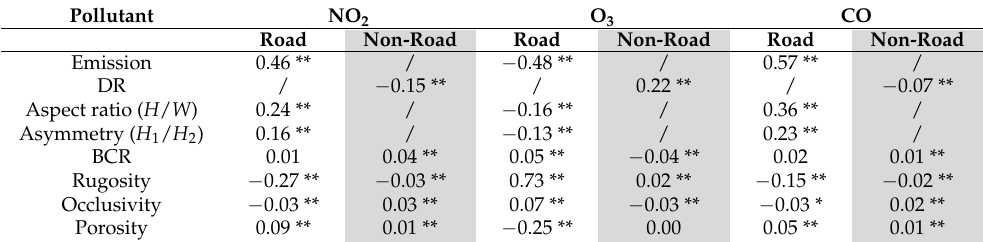
Table 4. Simple correlation coefficients between the standardized pollutants’ concentration (i.e., NO 2 , O 3 , CO) and individual standardized parameters over the road and non-road areas at the ground level. Pollutant NO 2 O